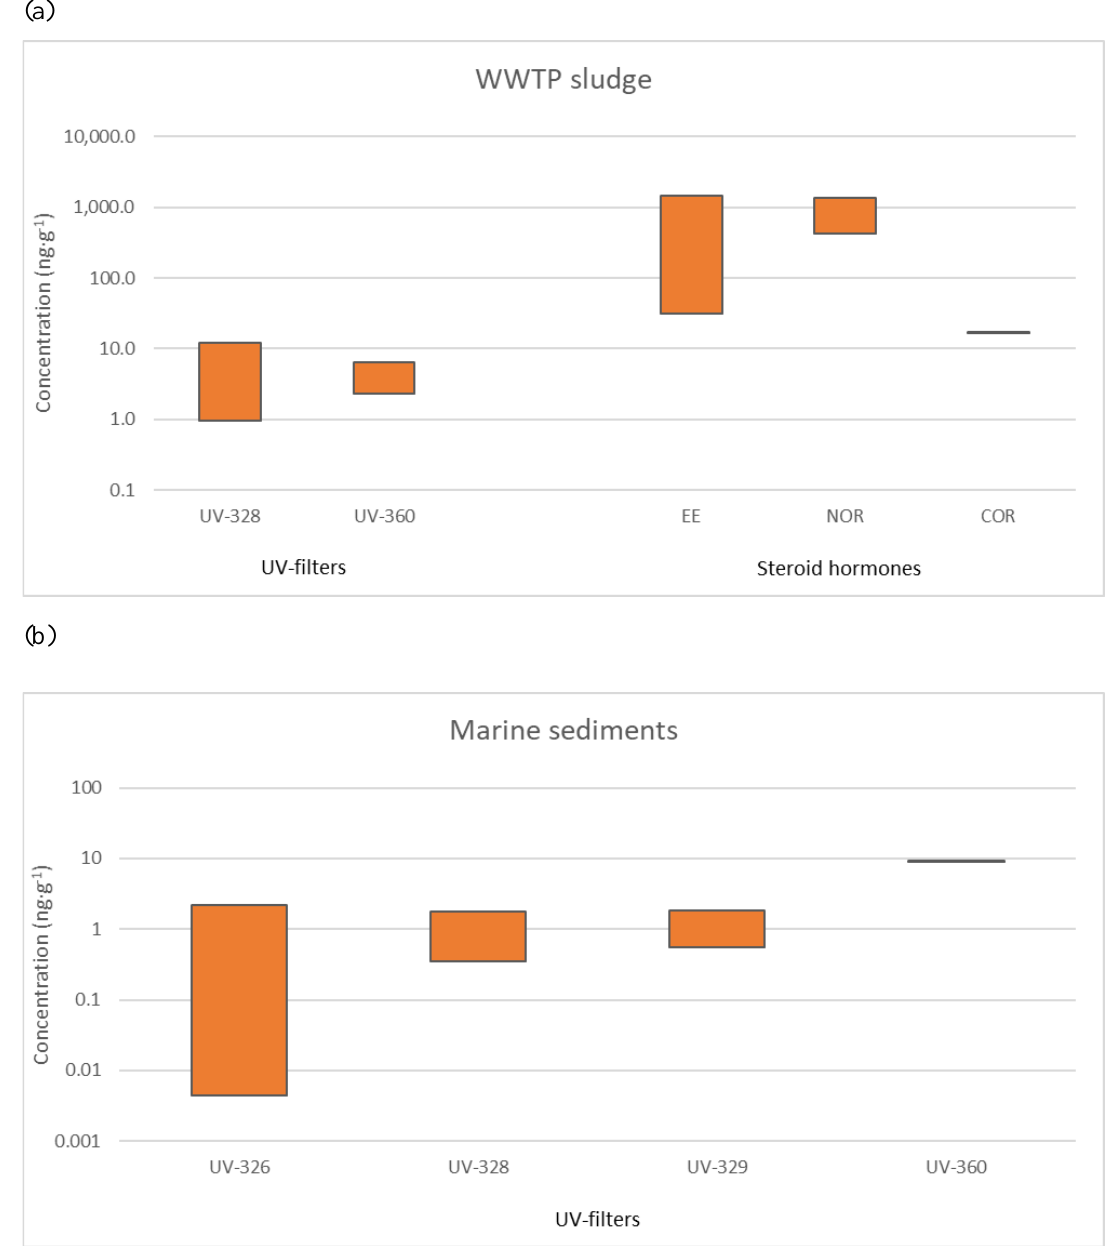
Figure 4. Range of concentrations (ng g −1 ) for detected emerging pollutants in ( a ) WWTP sludges and ( b ) marine sediments. ( b ) marine